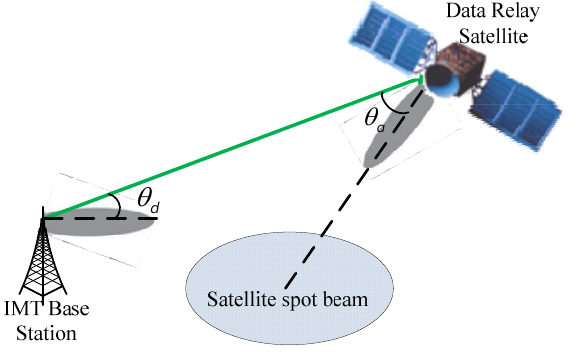
Fig. 4. Antenna radiation pattern for IMT-base station and data relay satellite